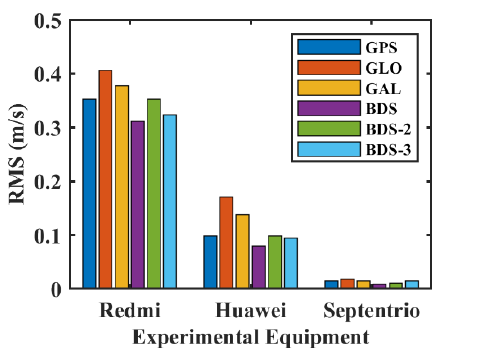
Figure 5. RMS histogram of velocity determination errors in horizontal directions of single-constellation.